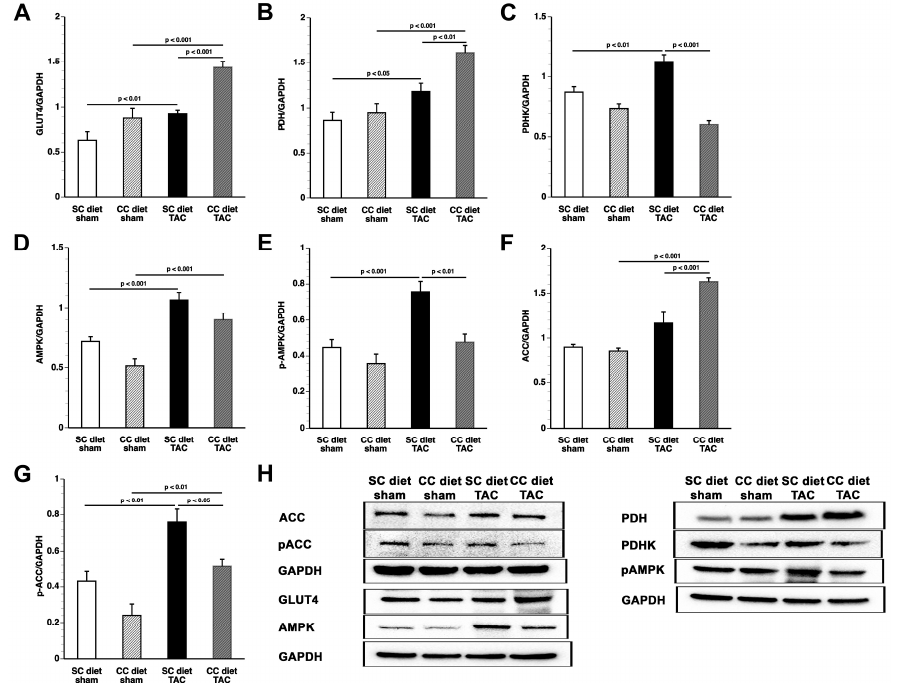
Figure 8. Quantification of metabolic proteins by Western blot. Intensities of immunoreactive bands on Western blots were quantified by densitometric analysis. Bar graphs illustrating: GLUT4 ( A ); PDH ( B ); PDHK ( C ); AMPK ( D ); p-AMPK ( E ); acetyl-CoA carboxylase (AAC) ( F ); and p-ACC ( G ) protein levels quantified by Western blot in the myocardium of SC diet sham ( n = 10), CC diet sham ( n =10), SC diet TAC ( n = 10), and CC diet TAC ( n = 10) mice eight weeks after operation. All protein levels were normalized to the glyceraldehyde-3-phosphate dehydrogenase (GAPDH) protein level. Representative images of Western blots are shown in panel ( H